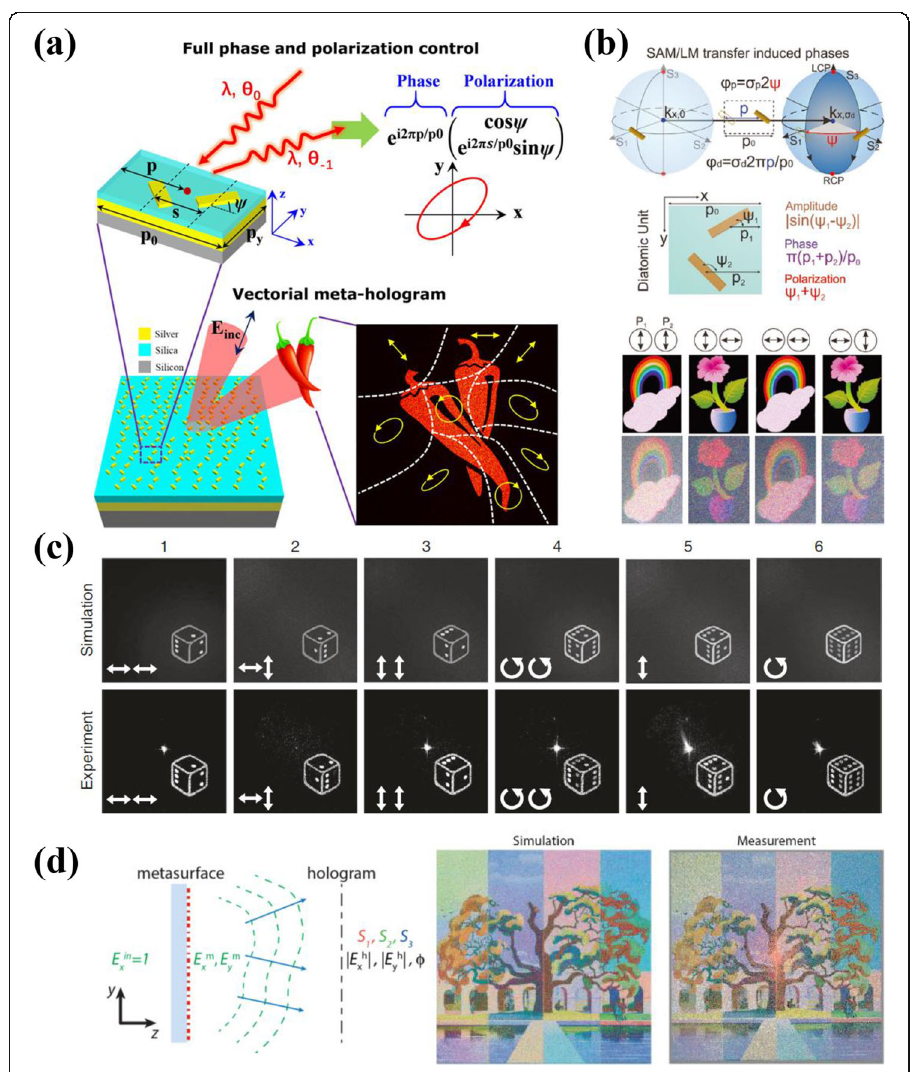
Fig. 3 Polarization-multiplexed metasurface holography. a The concept of diatomic metasurface based on detour phase principle for achieving vectorial holography [28]. b Design principle of the multi-freedom metasurfaces for completely controlling the amplitude, phase and polarization of output light simultaneously. The simulated and experimental results of reconstructed full-color images for different combinations of polarization orientations are shown on the bottom [29]. c Simulated and experimental results for the reconstruction of a dice with different exposed faces by using different combinations of input/output polarization [73]. d Schematic of a metasurface projecting a desired polarization pattern with arbitrarily complexity. Simulated and measured polarization holograms after converted to false-color images are shown on the right panel